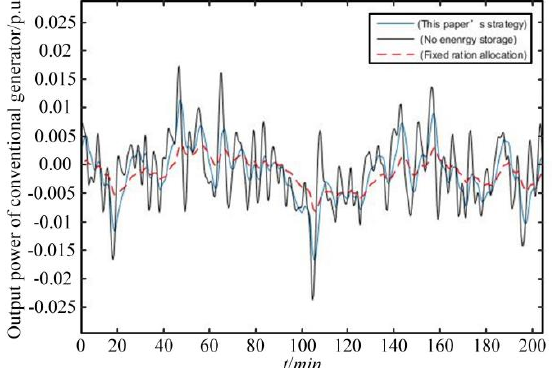
Figure 16. Output increment of conventional generator.